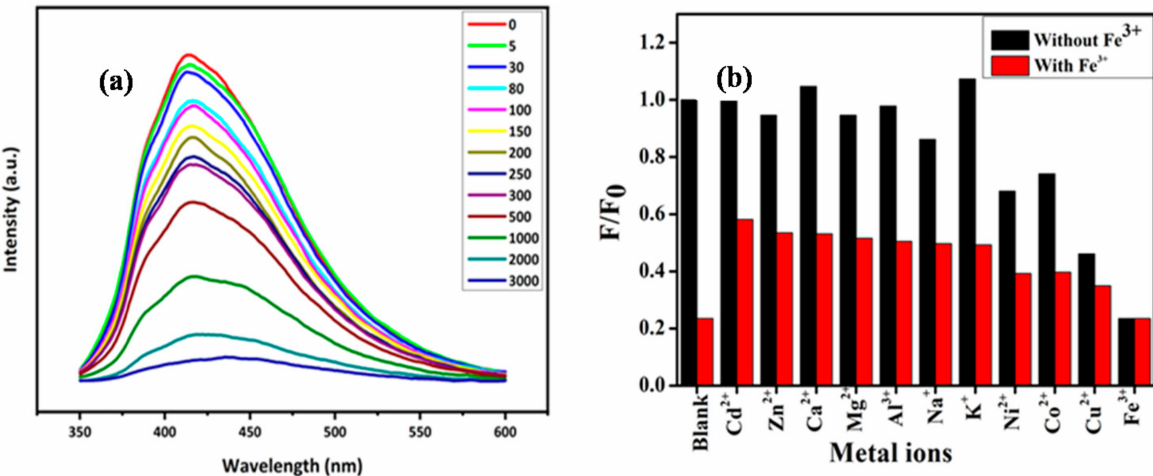
Figure 11. ( a ) Fluorescence spectra of NCSs with different concentrations of Fe 3+ (5–3000 µ M); ( b ) Changes in the fluorescence intensity ratio (F/F 0 ) of N-CSs after the addition of various metal ions. Adapted with permission from [77], Copyright {2021},